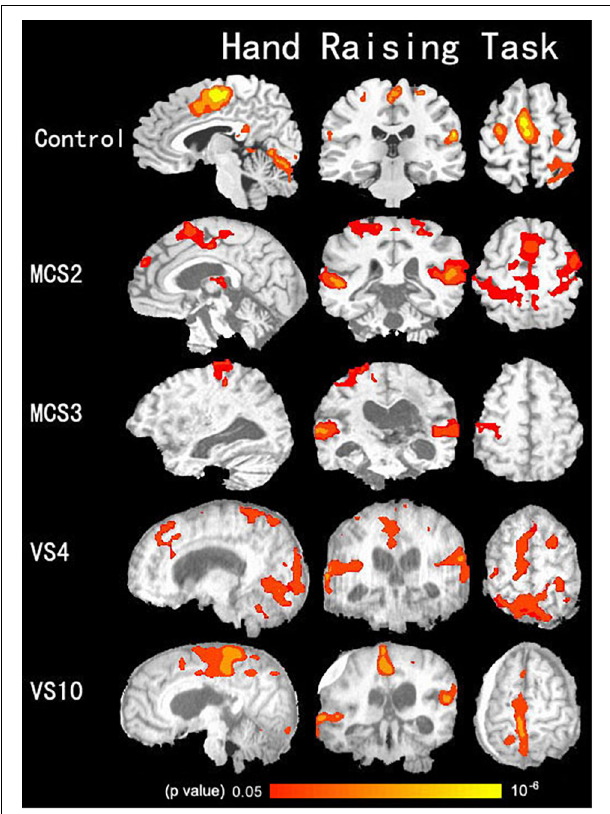
FIGURE 2 | Shows activation in the auditory cortex, the motor-related cortex (the supplementary motor cortex, primary motor cortex, anterior cingulated cortex, and the cerebellum) during the hand-raising task in two VS/UWS patients, two MCS patients, and 15 healthy volunteers in the control group ( p < 0.05,